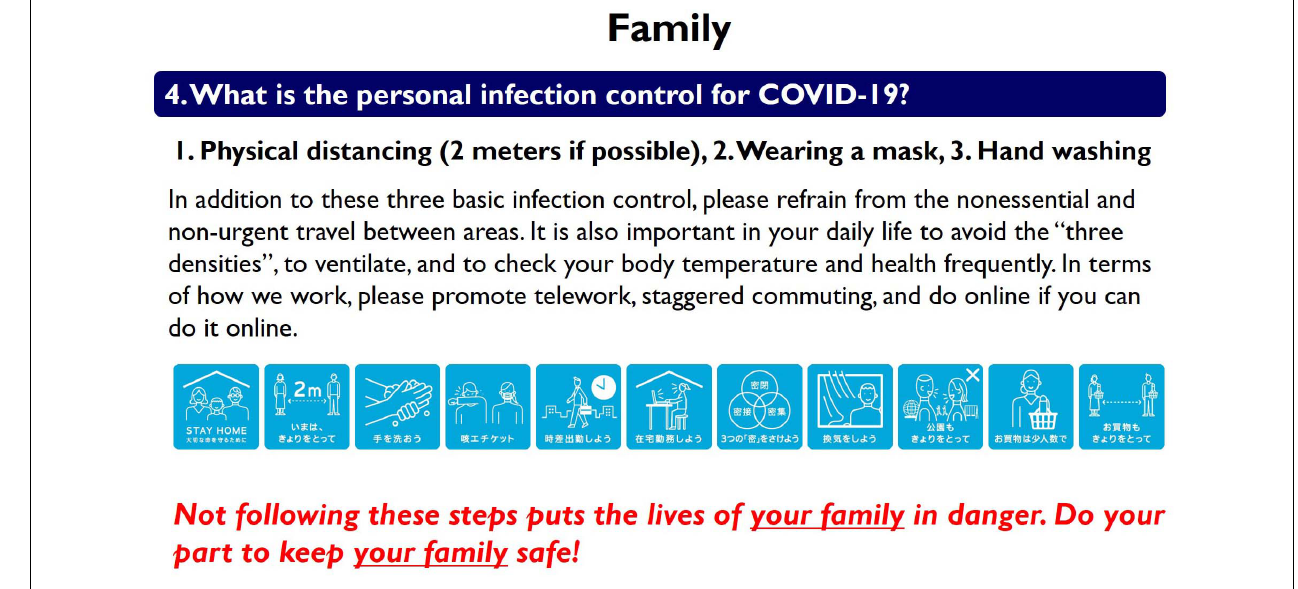
FIGURE 3 | Message shown in Family